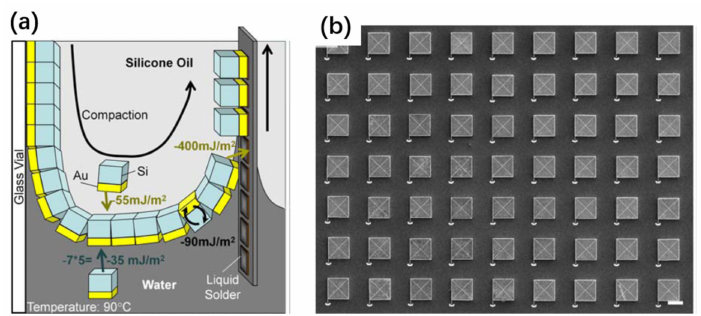
Figure 27. ( a ) Mechanism of surface tension-directed self-assembly at a liquid–liquid–solid interface. ( b ) SEM image of Si chiplets assembled in regular arrays. Adapted from